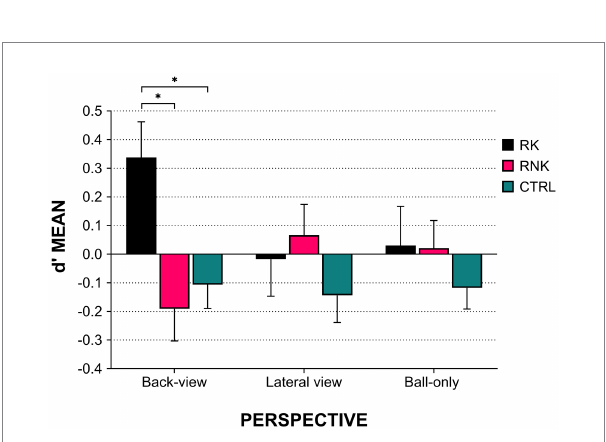
FIGURE 3 Kick outcome prediction according to group and perspective. The histograms indicate the average d ’ scores, error bars indicate standard error. Asterisks indicate post hoc values of p < 0.05. RK, Rugby Kickers; RNK, Rugby Non-Kickers; and CTRL, control